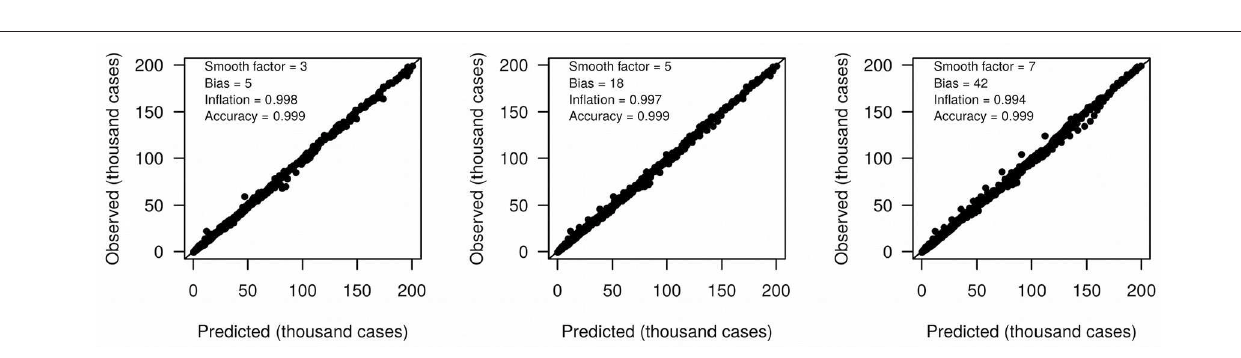
FIGURE 3 | Accuracy ( R 2 ) of moving regression predictions of next-day COVID-19